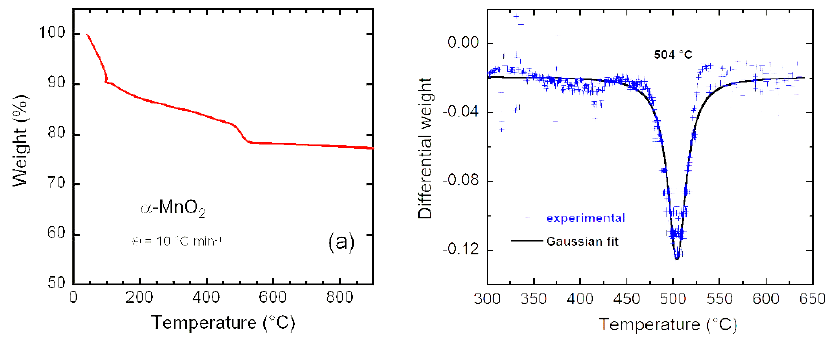
Figure 4. ( a ) TG curve of green synthesized K y MnO 2 nanoneedles. ( b ) Differential weight d W /d T showing the decomposition temperature from α-K y MnO 2 to Mn 2 O 3 .